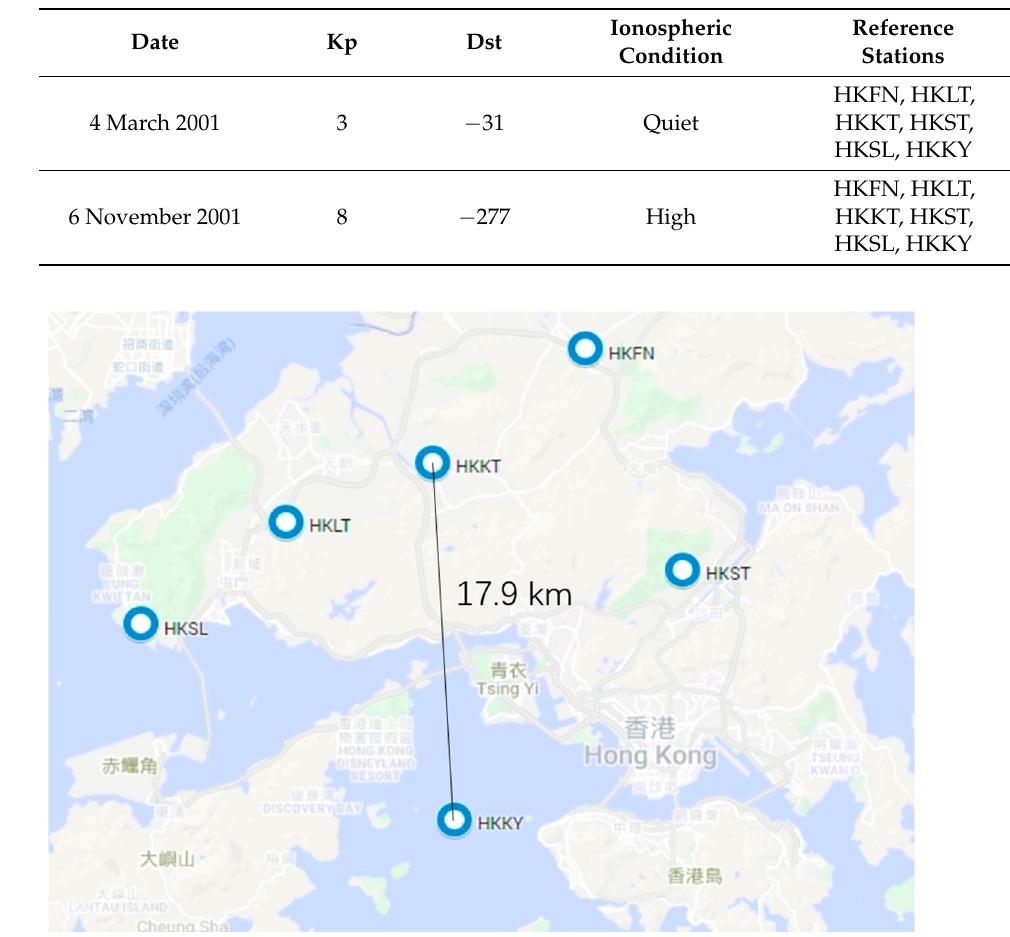
Figure 5. Distribution of selected reference stations in Hong Kong.